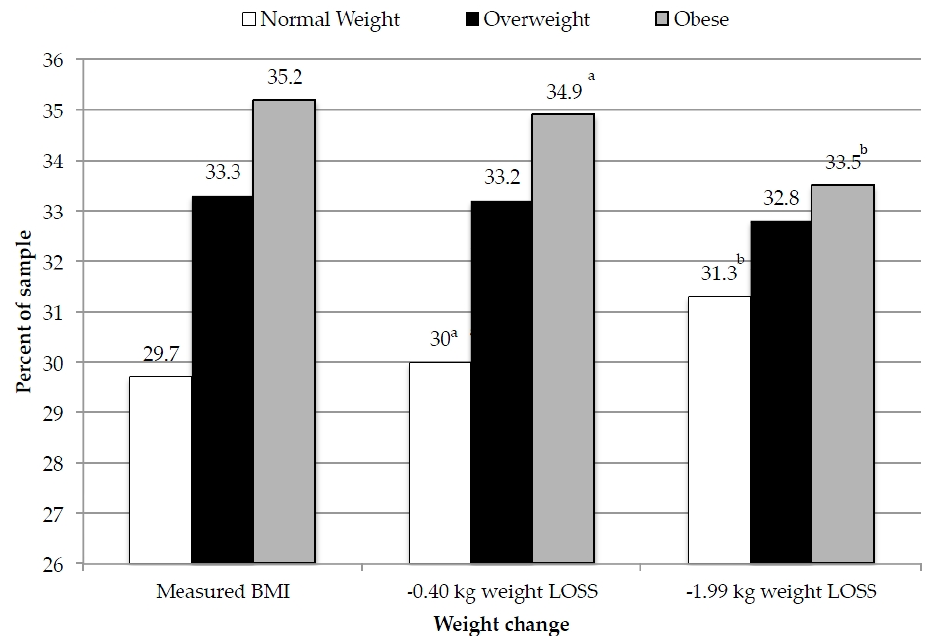
Figure 2. Percent of adults predicted as normal weight, overweight, or obese using predicted weight change [39] associated with substitution of one serving SSB with one serving water. Columns with different letters indicates statistical significance within weight category, p < 0.05 with Bonferroni correction for multiple comparisons.